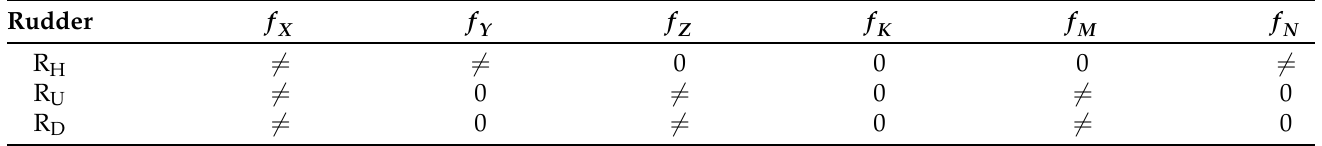
Table 2. Fault features of the rudder system outside the hull with 0 ◦ rudder